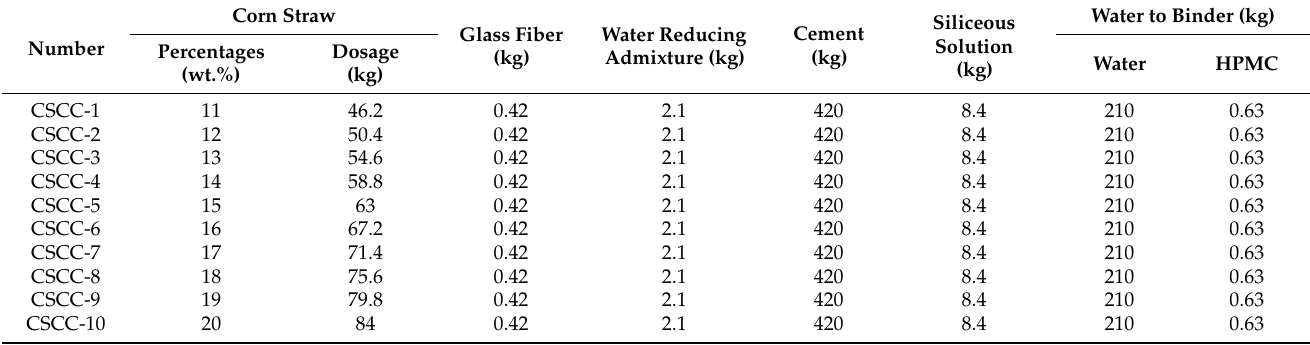
Table 4. Mix formulation of the composite samples with corn